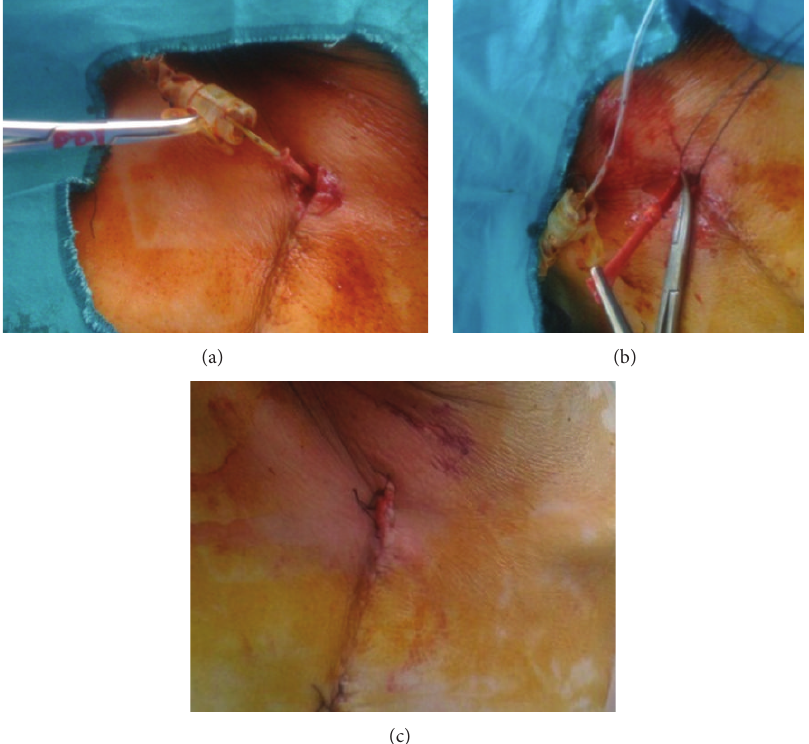
Figure 2: IABP removal and ligation of the graft. (a) The upper sternotomy incision is opened, the securing silk ligature is divided, and IABP catheter is gently removed. (b) A vascular clamp is applied to the graft. The vein graft is ligated at its base close to the sternum and the rest of the graft excised. (c) The graft stump is harbored into the subcutaneous tissue. Skin and the subcutaneous tissue are closed with interrupted